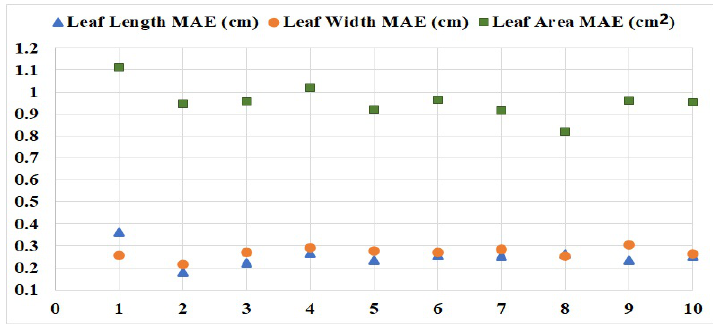
Figure 14. Values of mean absolute error (MAE) for leaves’ phenotypic characteristics.